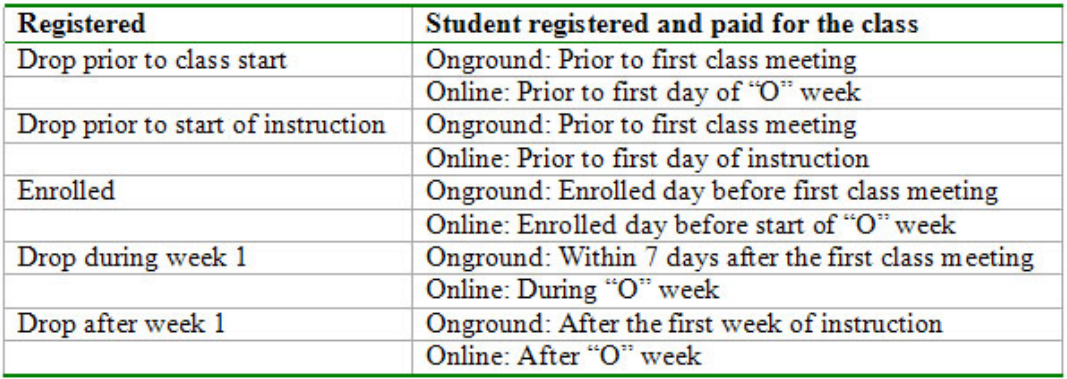
Table 2 . Definitions of dropout at different